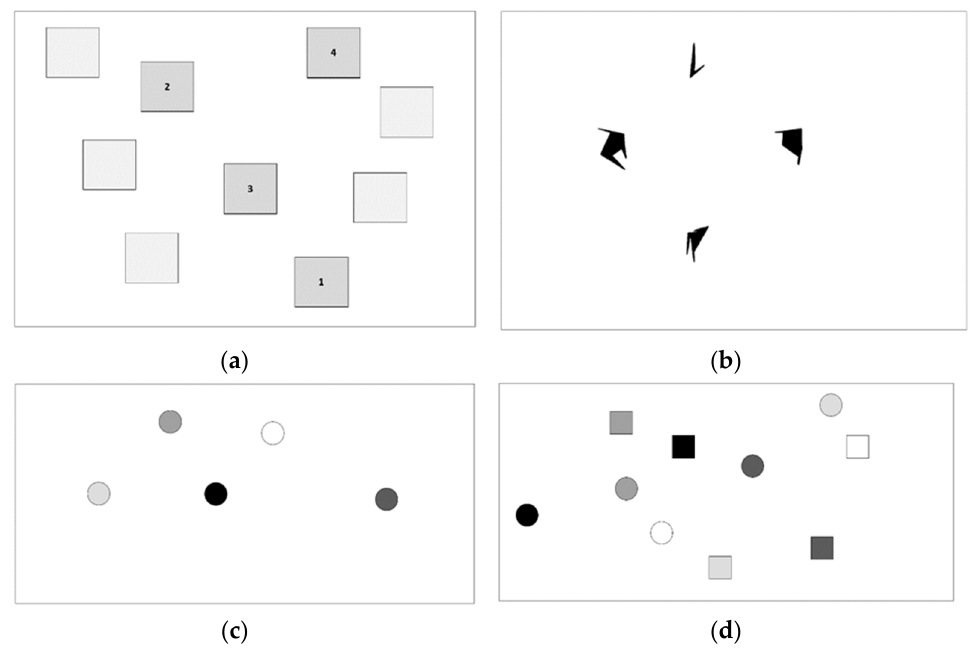
Figure 2. ( a – d ) Example Stimuli for Cognitive Tasks : ( a ) Example of Corsi Block set size 4. Numbers in square are used to demonstrate a sequential pattern but were not displayed to the participant. ( b ) Example of SOPT set size 4 with 4 different “Attneave” shapes, ( c ) Example of TMT A “Shades” pre-